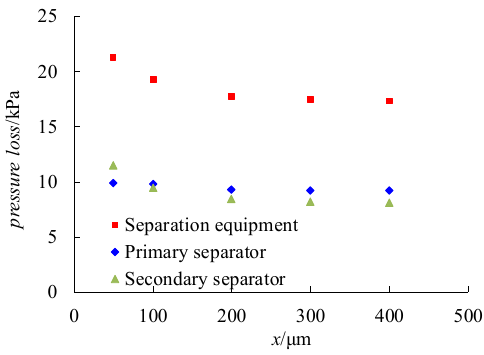
Figure 5. Pressure loss of separation equipment and each separator.